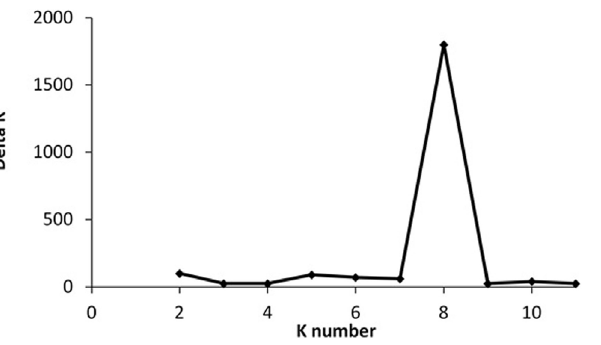
Fig. 4. Delta K values with respect to K (number of groups) according to the calculation method by Evanno et al . [26] . These results were obtained based on the analysis of 23 SSR markers in 167 accessions of sweet potato from the agricultural experimental station in Gurabo, Puerto Rico (12 accessions), the plant genetic resources conservation unit in Griffin, GA (22 accessions) and 137 Puerto Rico landraces.